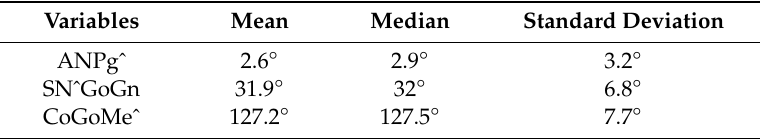
Table 1. Cephalometric values in the study